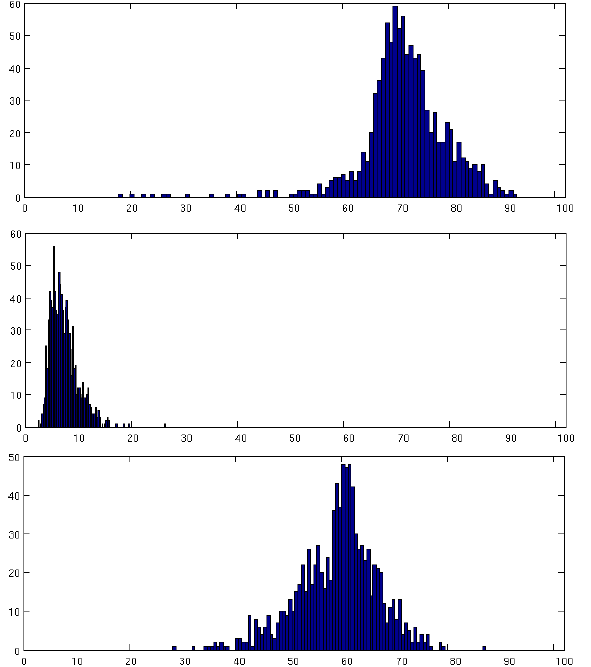
Figure 7: Histograms of the CCH mean values from 1995 road patches in the HSV color space. From top to bottom: H, S, V.